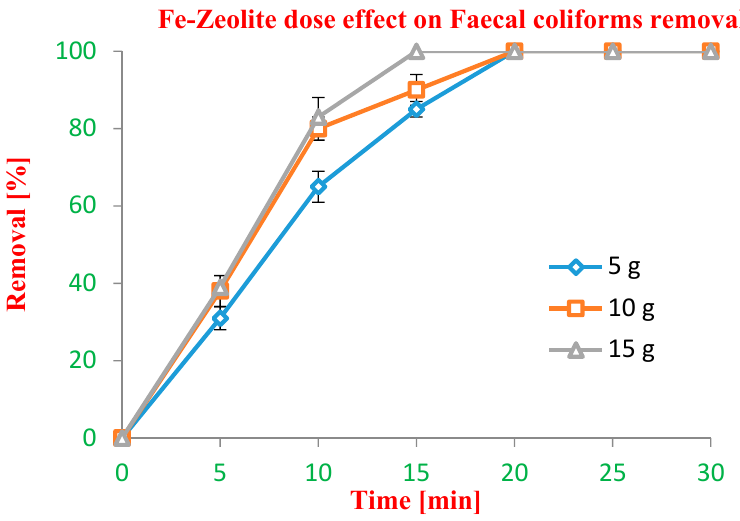
Figure 9. Catalyst dose effect (initial faecal coliforms = 18 ± 4 MPN/100 mL, ozone dose = 0.2 mg/min, O 3 /Fe-ZA dose = 5 g/L, 10 g/L and 15 g/L, O 3 = 0.2 mg/min, pH = 8.3 ± 2, Volume = 1 L, time = 30 min, T = 33 ± 2 °C).